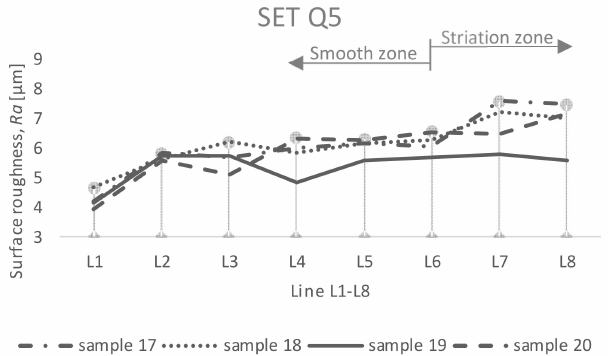
Figure 9. Evaluation of surface topography created by the AWJ (set